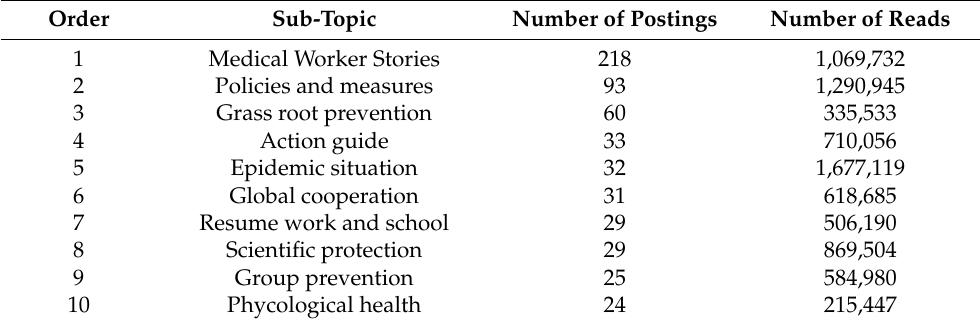
Table 4. Public attention (reads) on different sub-topics of the government at control stage of COVID-19.